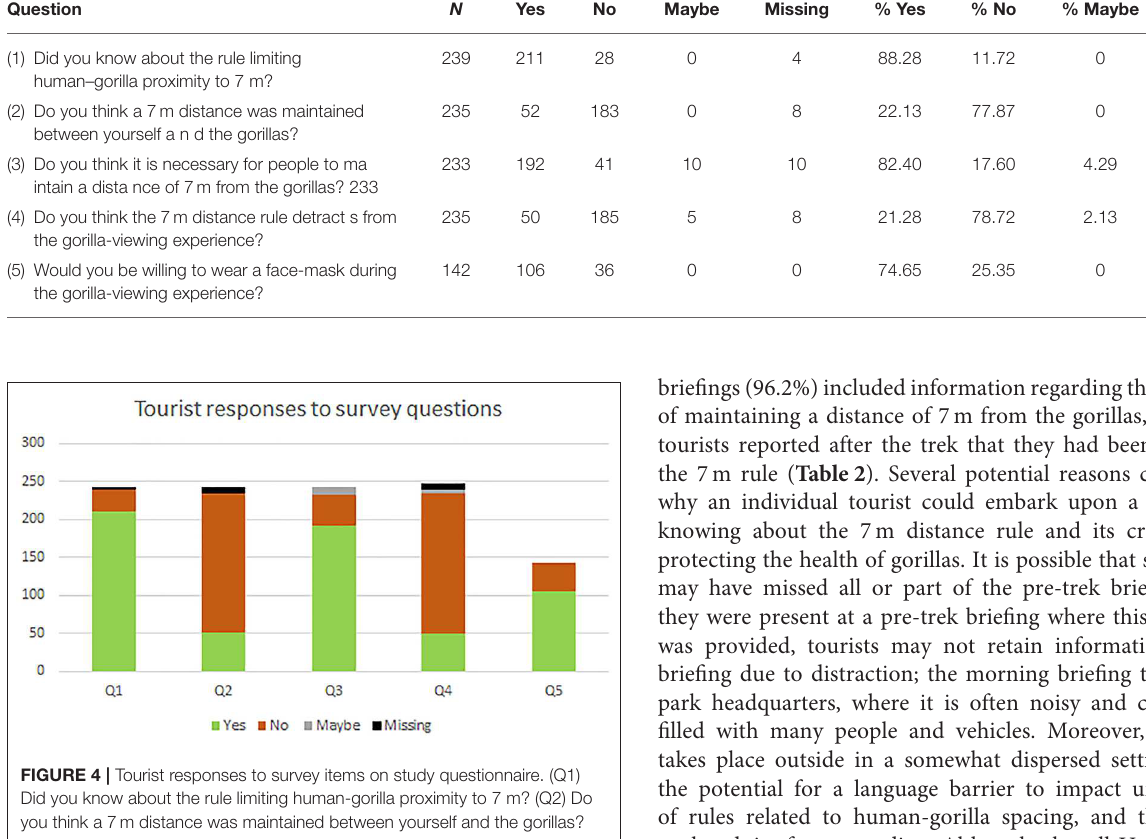
TABLE 2 | Survey questionnaire questions and responses. Question N Yes No Maybe Missing % Yes % No % Maybe % Missing